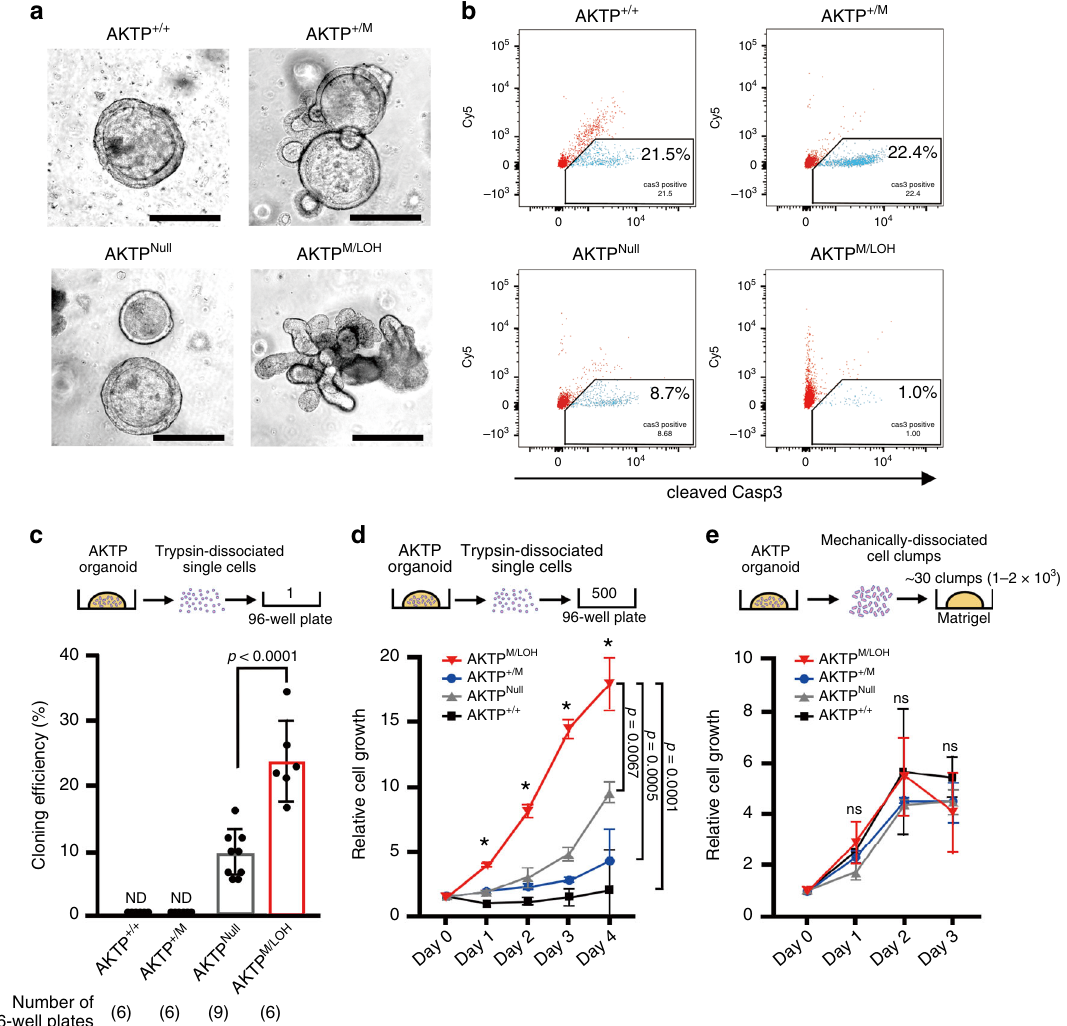
Fig. 4 Increased survival of dissociated tumor cells by Trp53 GOF mutation with LOH. a Representative photographs of four AKTP organoid lines with different Trp53 genotypes (AKTP + / + , AKTP + /M , AKTP Null , and AKTP M/LOH ). Bars, 500 µ m. Note that AKTP M/LOH cells formed a complex glandular structure, while other organoids showed a round cystic structure. The images are representative of six independent cultures. b A fl ow cytometry analysis for cleaved caspase 3 (Casp3) of trypsin-dissociated cells of the four different Trp53 genotypes. Gating strategy is shown in Supplementary Fig. 5. The apoptosis rate is indicated in each graph. c Cloning ef fi ciencies examined by limiting dilution of trypsin-dissociated single cells in 96-well plates are shown as a bar graph. The numbers of 96-well plates used for each genotype analysis are indicated in parentheses. Cloning ef fi ciency was calculated in each 96-well plate, and the mean cloning ef fi ciency was calculated ( n = 6 – 9 biologically independent samples). Gray-line bar, AKTP Null cells; red-line bar, AKTP M/LOH cells; and ND, not detected. d , e The results of a cell proliferation assay of trypsin-dissociated single AKTP cells (500 cells/well) ( n = 3 biologically independent samples) ( d ) and mechanically dissociated AKTP cell clumps (~30 clumps containing 1 – 2 × 10 3 cells/Matrigel) ( n = 3 biologically independent samples) ( e ). Red lines with triangles, AKTP M/LOH cells; blue lines with circles, AKTP + /M cells; gray lines with triangles, AKTP Null cells; and black lines with squares, AKTP + / + cells. The relative cell growth compared to the day 0 level is indicated. Data are presented as mean ± s.d. The data in c were analyzed by two-sided unpaired t -test, p values are provided; ND, not detected. The data in d , e were analyzed by ANOVA test, * p < 0.0001; ns,